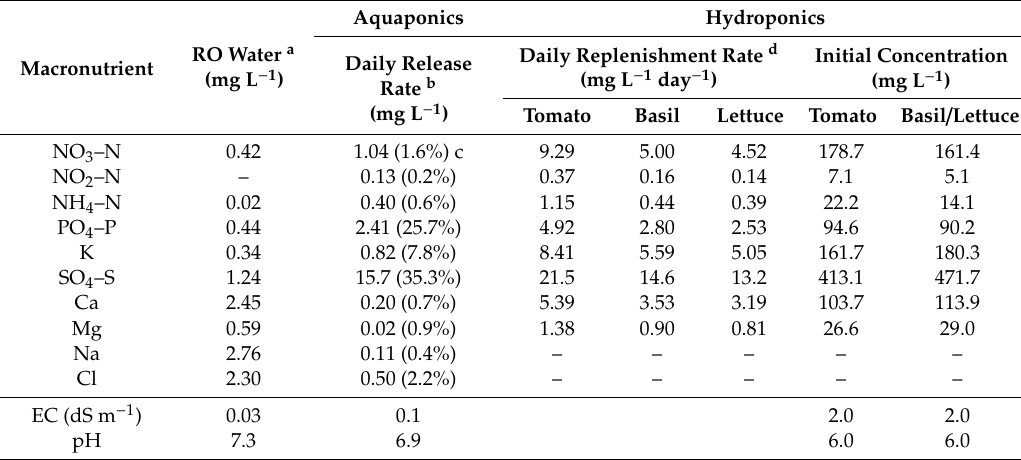
Figure 1. Schematic diagram of experimental units: ( A ) aquaponic system; ( B ) hydroponic system, adapted from Yang and Kim (2019) [4]. Table 1. Composition and concentration of nutrient sources used in tomato-, basil-, and lettuce-based aquaponic and hydroponic systems.